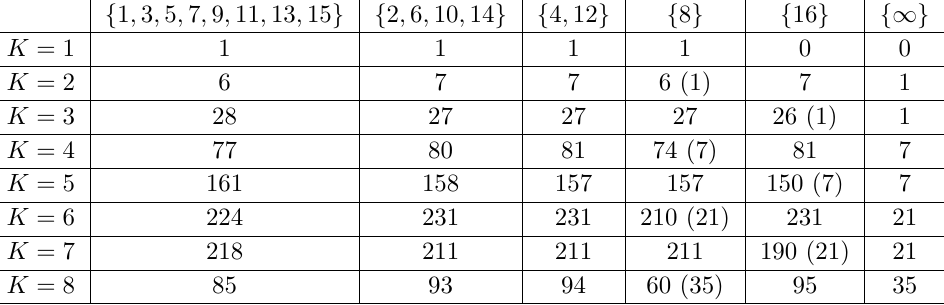
Table 13 . Number of Bethe roots for decomposed BAE with M =